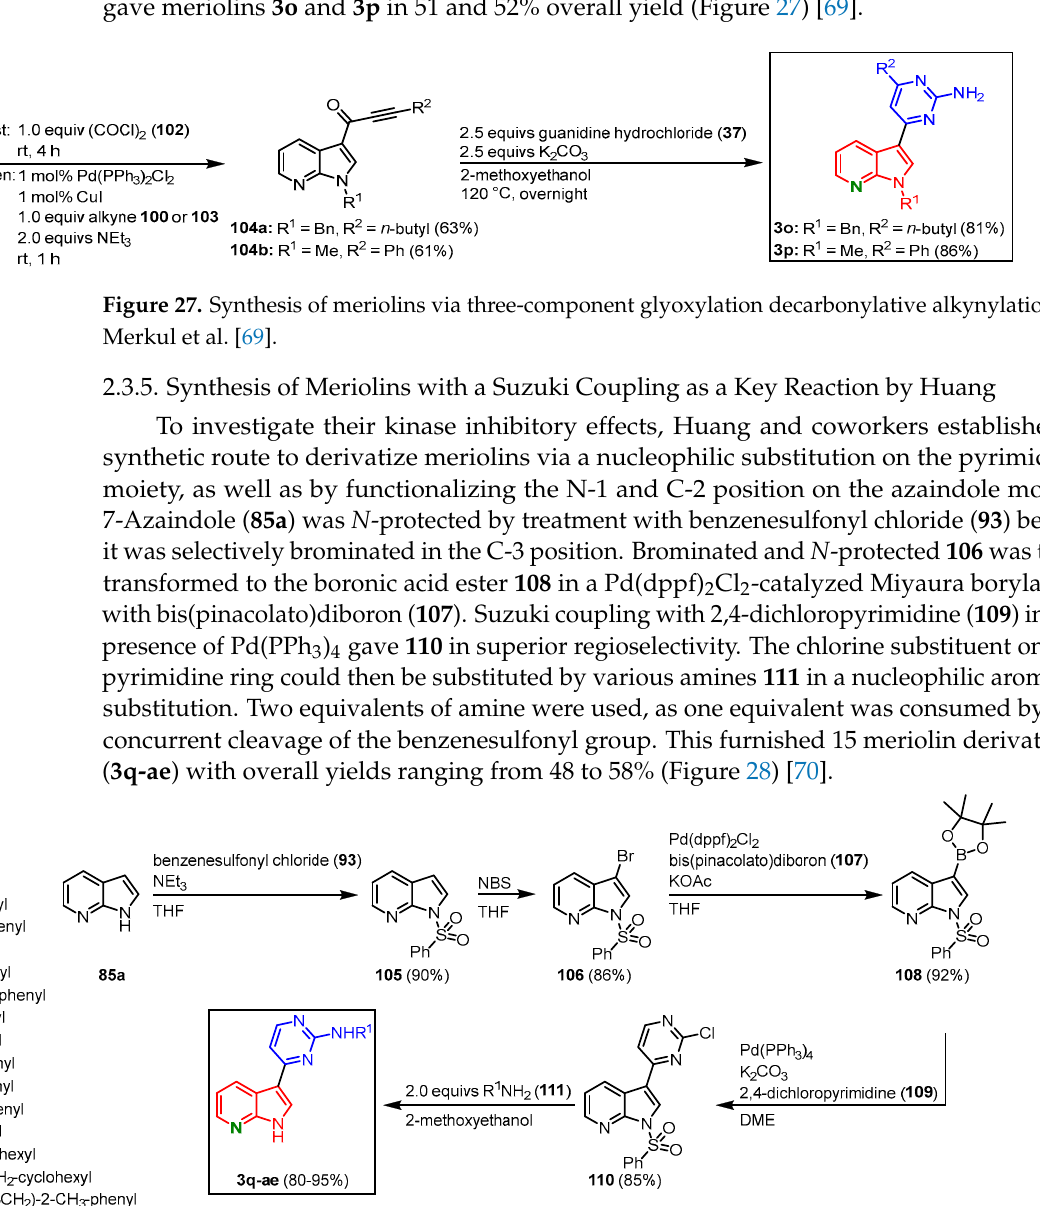
Figure 26. Synthesis of meriolins 3a and 3n via carbonylative alkynylation and subsequent pyrimidine synthesis by Müller [61,68].